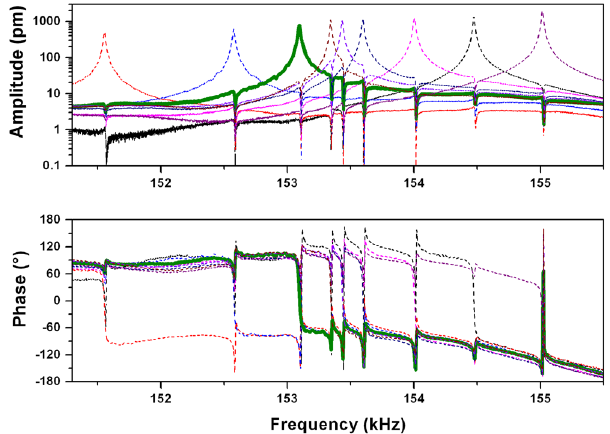
Figure 2. Fano resonances in amplitude and phase spectra. Vibration spectra and phase signals of all the cantilevers of the MC_9 array, centered around the second resonance mode. The spectrum of the central cantilever is represented with a thick continuous line, while all the others by dotted